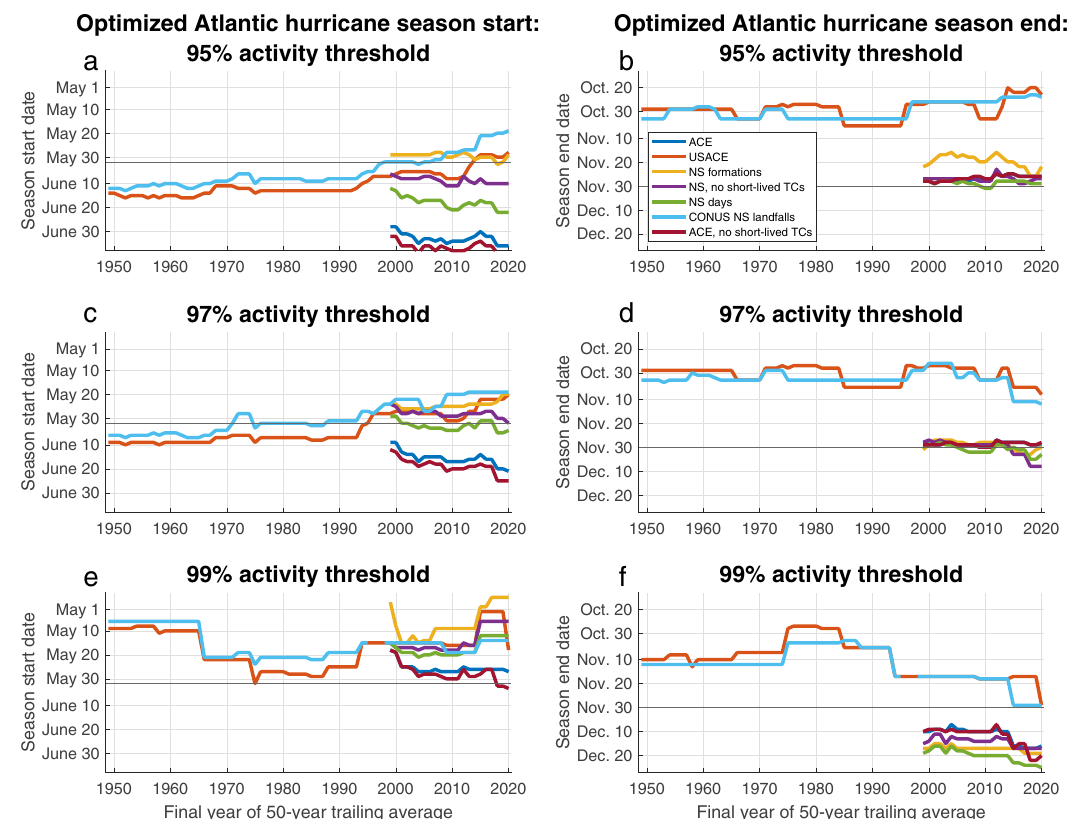
Fig. 4 Objectively determined Atlantic hurricane season bounds. a , c , e Starting and ( b , d , f ) ending dates of the most compact timeframe capturing ( a , b ) 95%, ( c , d ) 97%, and ( e , f ) 99% of tropical cyclone (TC) activity, as de fi ned by Atlantic Accumulated Cyclone Energy (ACE), ACE over the continental United States (USACE), named storm (NS) formations, named storm formations excluding short-lived TCs, named storm days, continental United States (CONUS) named storm landfalls, and Atlantic ACE excluding short-lived TCs. Objective calculation of dates are performed using timeseries with 50-year trailing averages of activity and 15-day smoothing of intraseasonal climatology. Trailing averages begin with 1900 – 1949 for landfalls and USACE, and 1950 – 1999 for all other